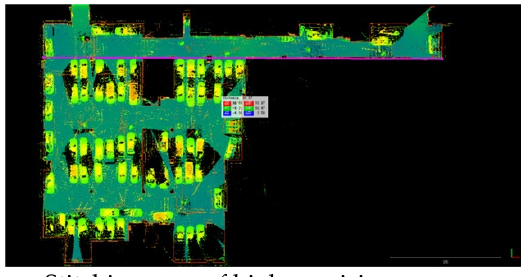
Figure 7. The ground-truth of indoor 3D map.